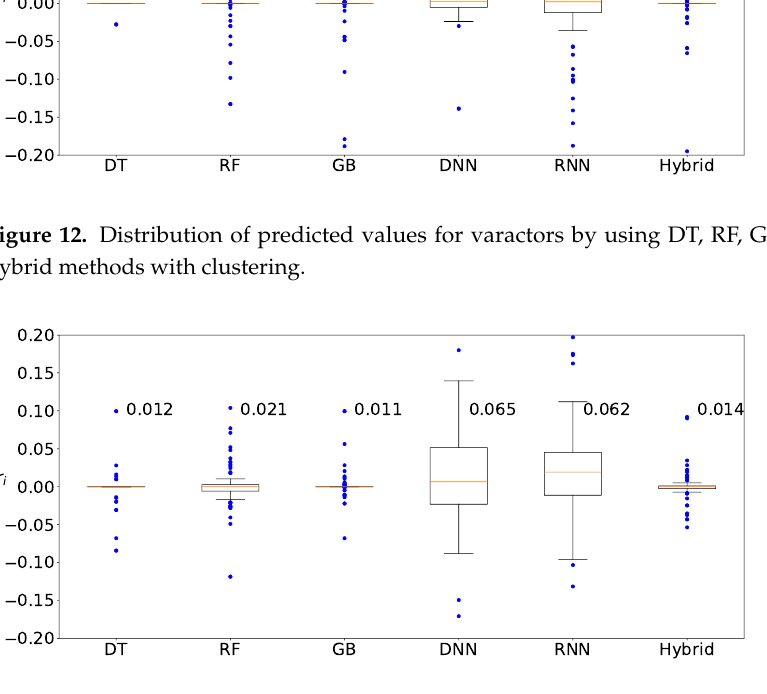
Figure 13. Distribution of predicted values for bridge rectifier diodes by using DT, RF, GB, DNN, RNN, and hybrid methods with